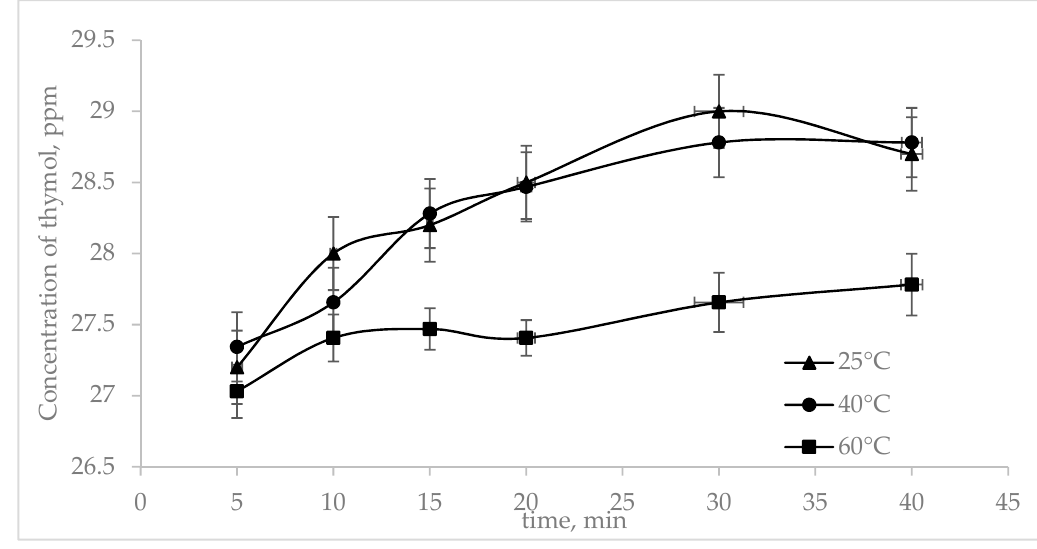
Figure 4. Kinetic study of thymol extraction at different temperatures.